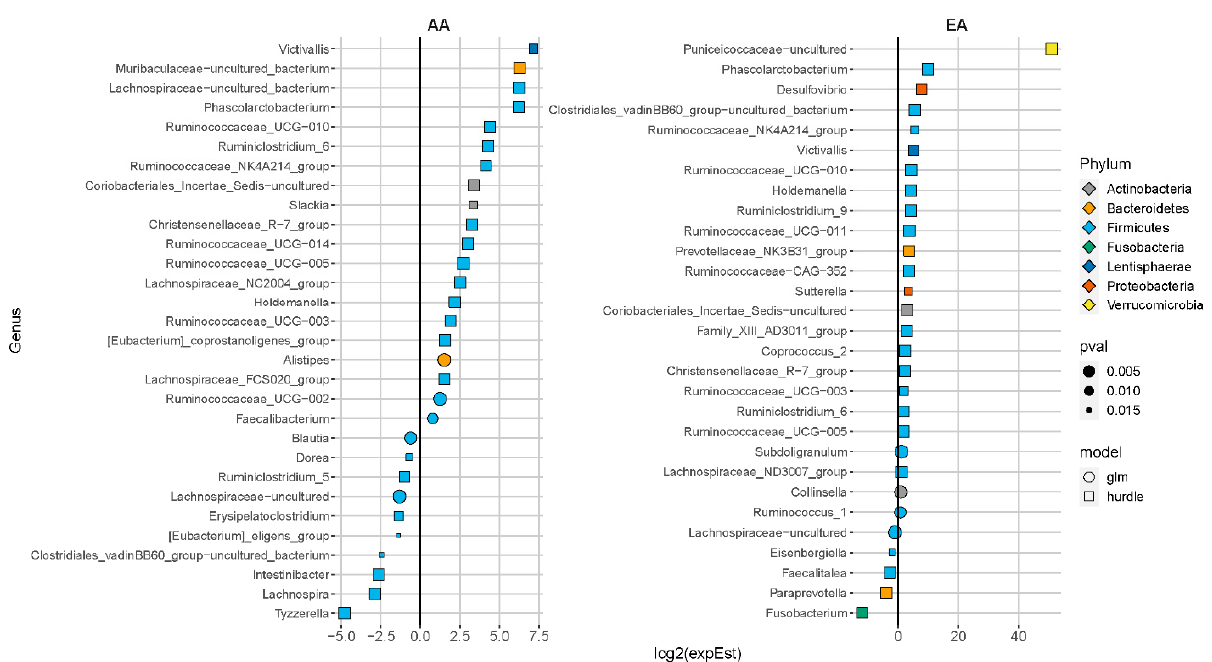
Figure 3. Differentially abundant genera associated with enterolactone excretion at baseline in women of African ancestry (AA) and European ancestry (EA); adj p < 0.05. Genera with less than 1% zeros across samples were fit with a negative- binomial generalized linear model (GLM) otherwise, a hurdle model was used. Models were adjusted for baseline age, body mass index (kg/m 2 ), total dietary fiber (g/d), energy intake (kcal/d), and total flaxseed consumption during the intervention period (g).